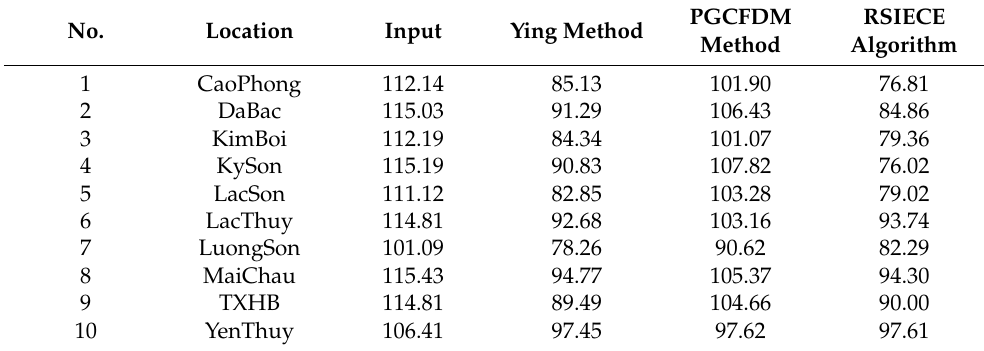
Table 3. Standard deviation index of enhanced images by the RSIECE algorithm compared to the Ying and PGCFDM methods.